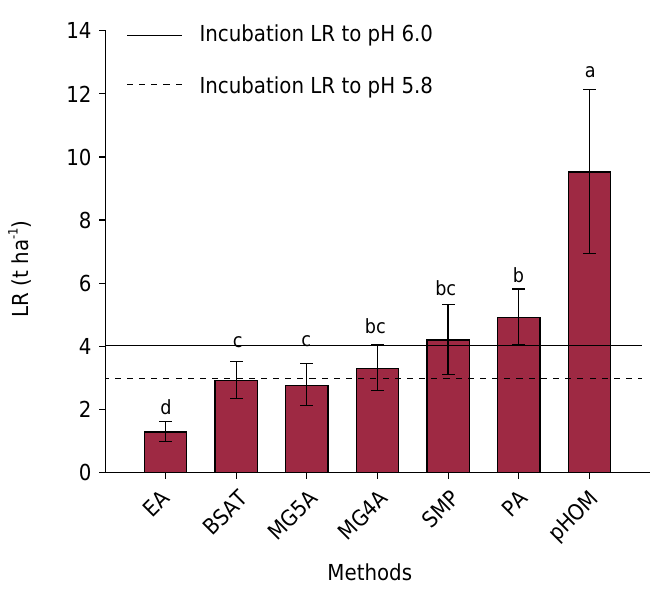
Figure 2. Lime requirement (LR) determined from the exchangeable acidity (EA), base saturation (BSAT), 5th Approximation to Minas Gerais State (MG) (MG5A), 4th Approximation to MG (MG4A), Shoemaker-McLean-Pratt buffer (SMP), potential acidity (PA), and soil pH-organic matter (pHOM) methods. Data plotted as means of the 22 soils used in the incubation study. Dashed and solid lines indicate the mean LR determined from incubation to raise soil pH to 5.8 and 6.0, respectively. Means followed by the same letter are not significantly different (p>0.05, Tukey test). Error bars represent 95 % confidence